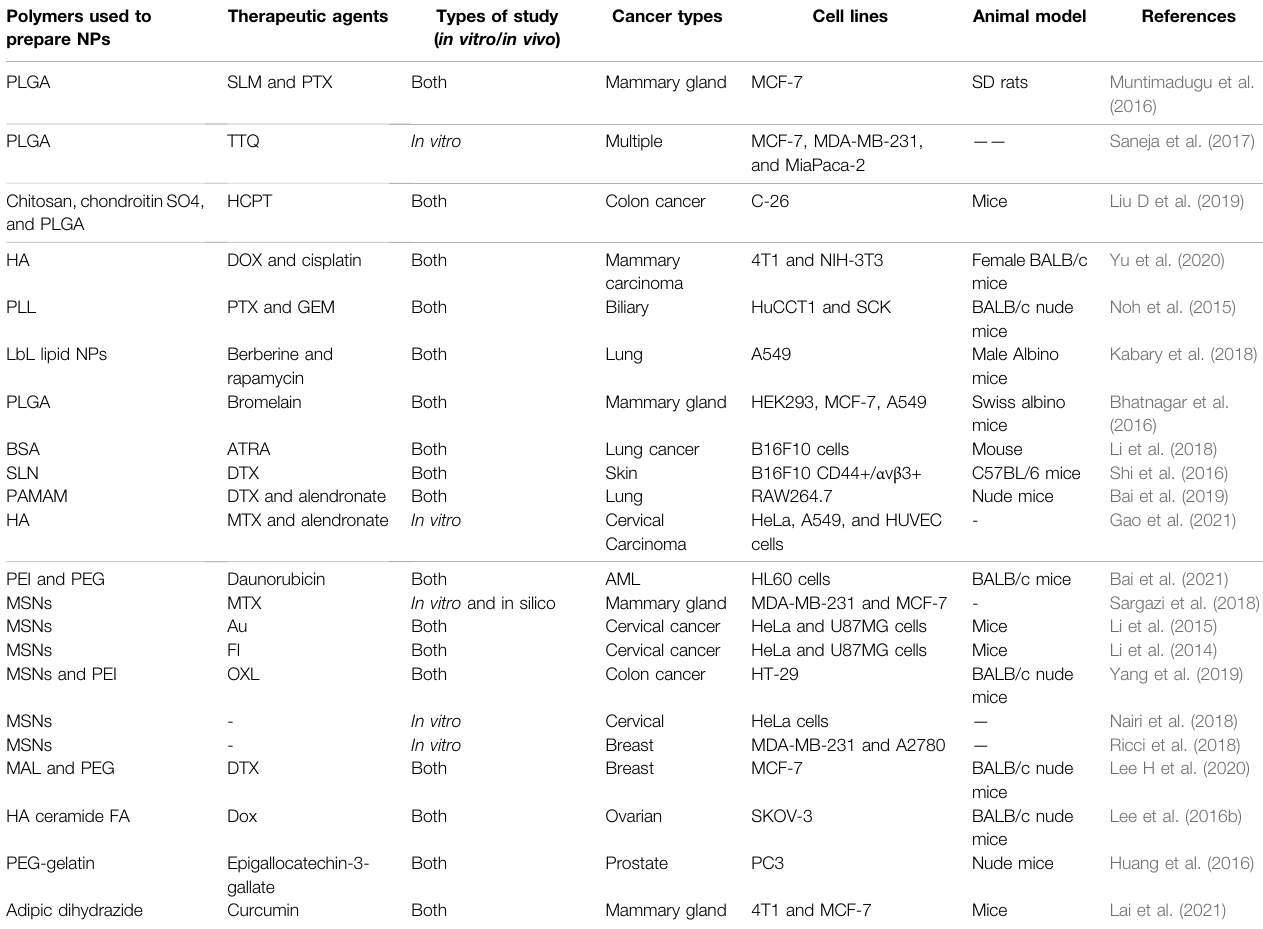
TABLE 2 | Outline of nanoparticle-targeted CD44 cells against cancer. Polymers used to prepare